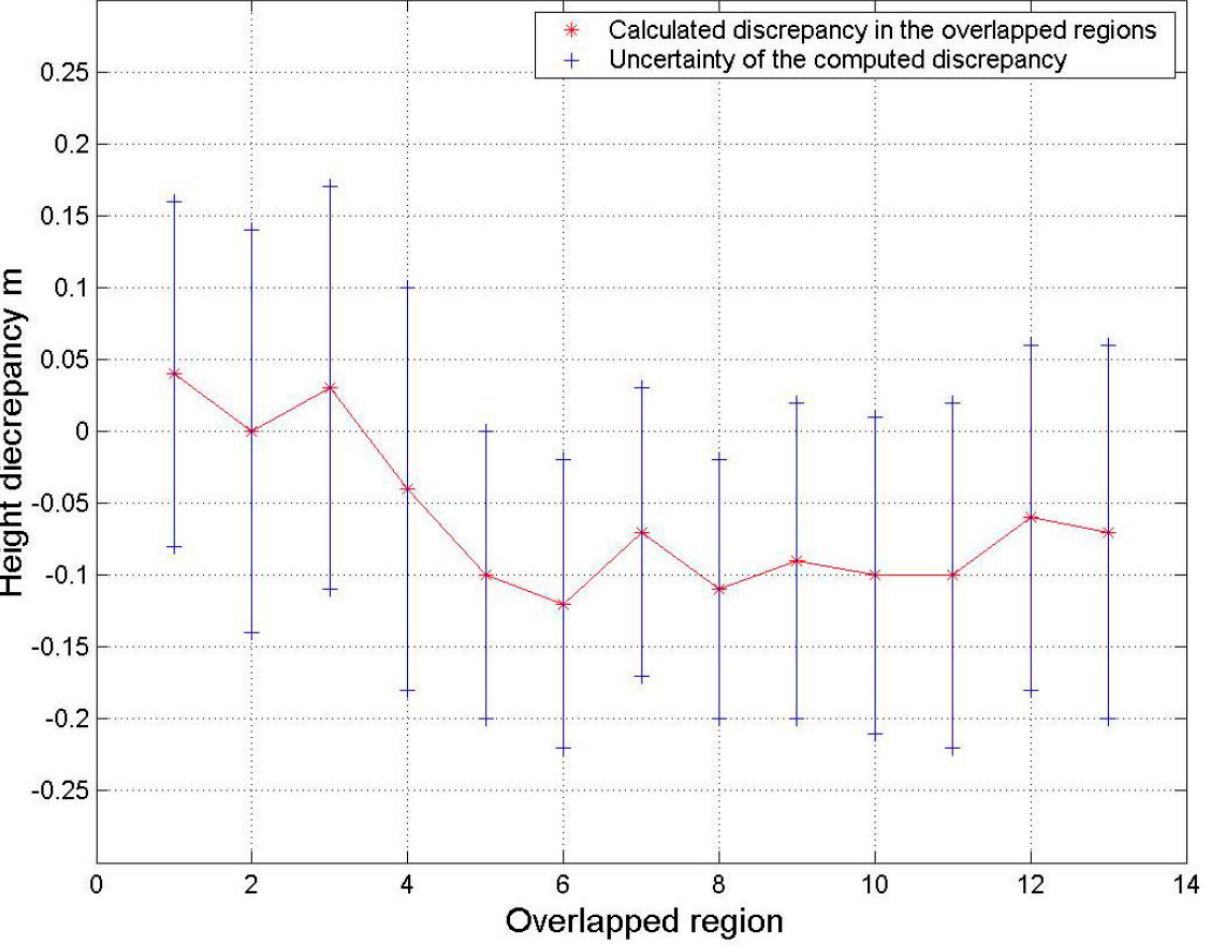
Figure 5. Mean Relative discrepancy behavior between adjacent strips, where the x ‐ axis represents the overlap regions (where 1 is the overlap region between strip one and two).